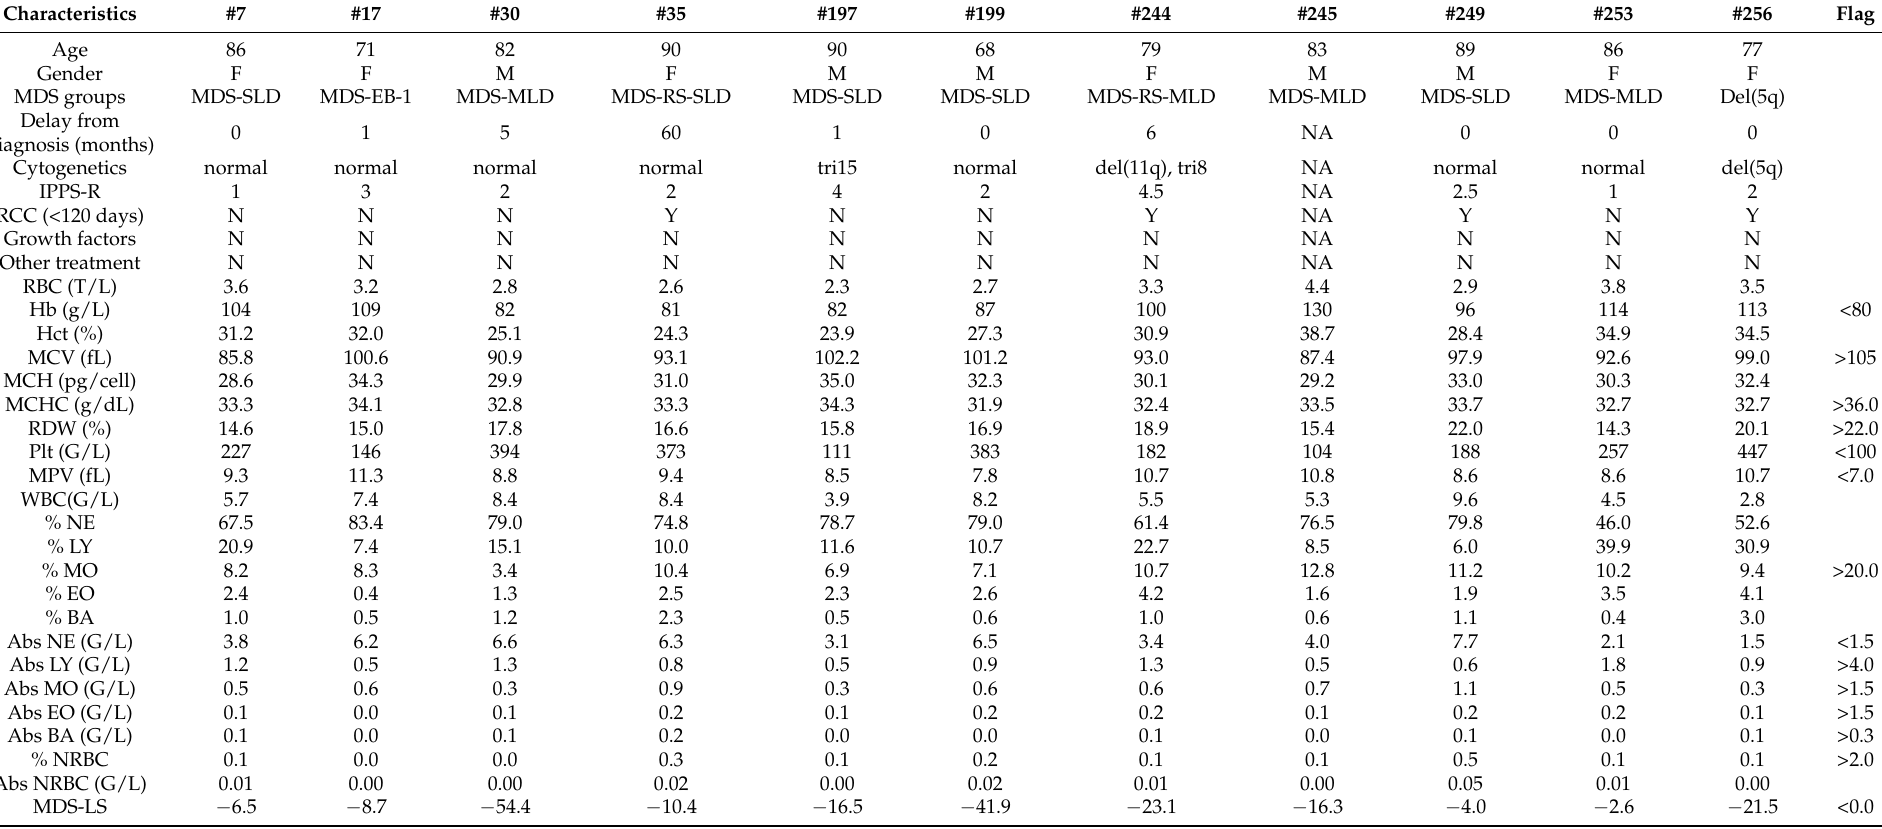
Table 1. Clinical and Biological Characteristics of the 11 Myelodysplastic Syndrome MDS Patients for Whom MDS-Likelihood Score (LS) Would Have Triggered Blood Smear Review, While Complete Blood Count (CBC) Did Not Generate Any Conventional